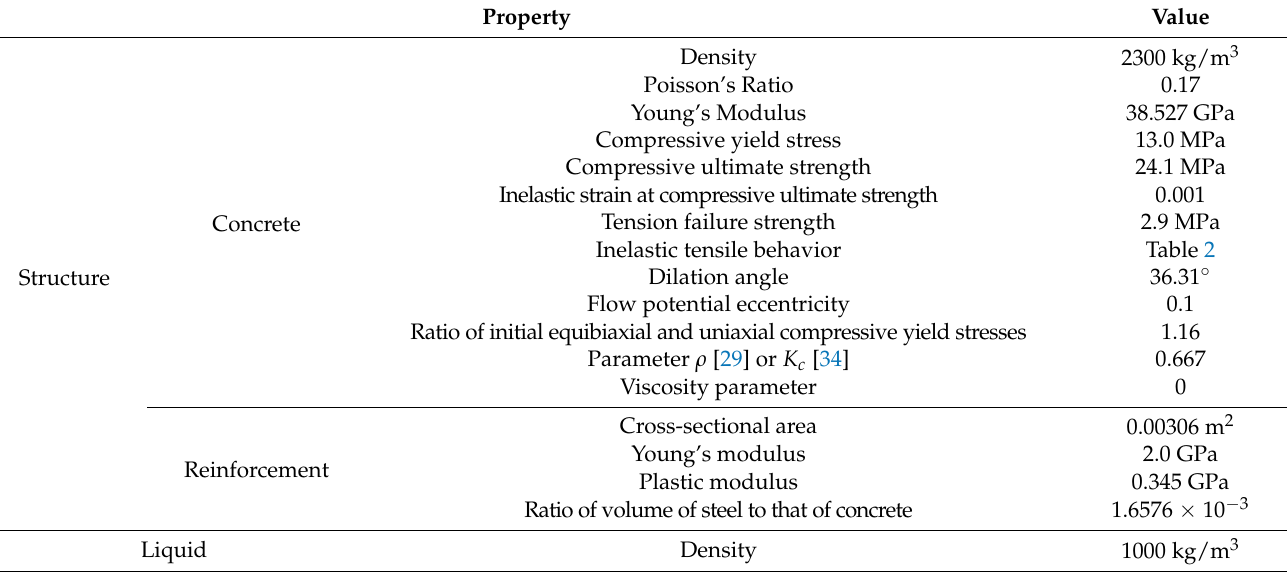
Table 1. Material properties of a rectangular liquid tank.